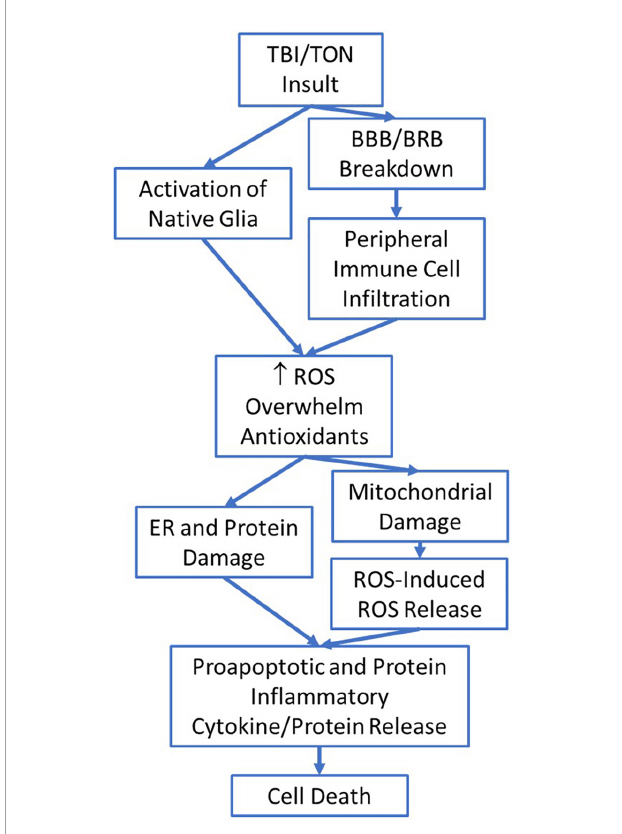
FIGURE2 The potential flow of injury mechanisms and steps involved after traumatic brain injury (TBI)/traumatic optic neuropathy (TON) which eventually lead to cell